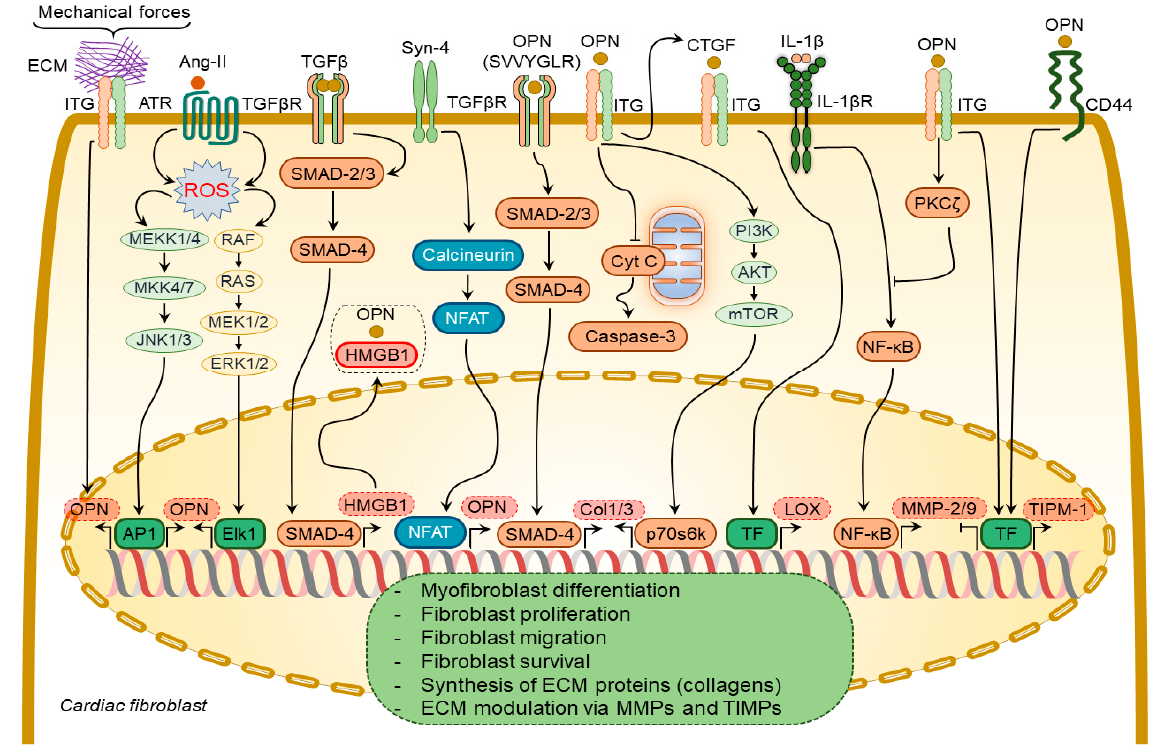
Figure 3. Osteopontin signaling in cardiac fibroblasts. A number of factors induce osteopontin (OPN) expression in cardiac fibroblasts including angiotensin-II (Ang-II), syndecan-4 (Syn-4), and mechanical forces. In turn, osteopontin regulates several processes in cardiac fibroblasts via modulating certain signaling pathways. These processes include binding of osteopontin to high mobility group box 1 (HMGB1) to form focal adhesions in cardiac fibroblasts; TGF β R activation via its SVVYGLR motif and subsequent induction of collagen-1 and -3 (Col1/3) expression; enhancement of Col1/3 expression via integrin receptor-mediated signaling pathways; inhibition of cardiac fibroblast apoptosis via blocking the release of cytochrome C (Cyt C) from mitochondria; inhibition of the activity and expression of MMP-2/9 induced by interleukin-1 β (IL-1 β ) signaling pathway; induction of tissue inhibitor of metalloproteinases 1 (TIMP-1) expression via integrin- and CD44-mediated signaling pathways. The overall effect of osteopontin signaling in cardiac fibroblasts results in myofibroblast differentiation, proliferation, migration, and survival, synthesis of extracellular matrix (ECM) proteins, and modulation of ECM via regulating expression of MMPs and